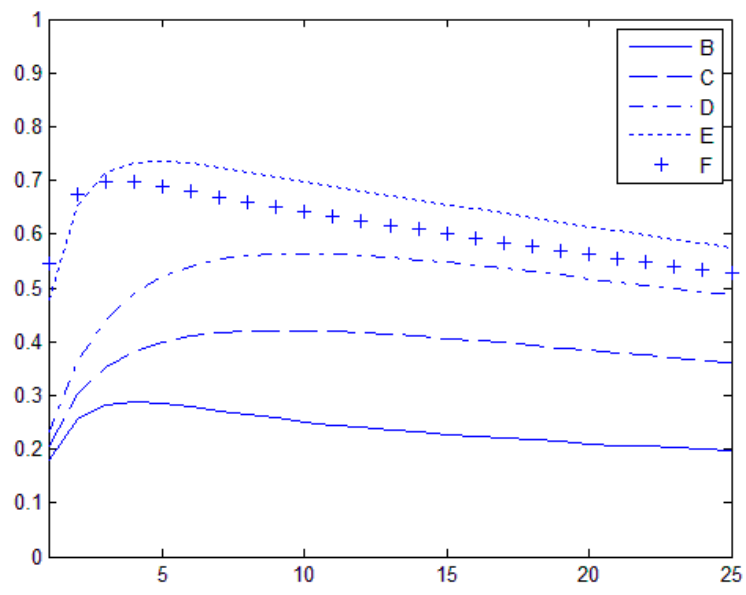
Figure 1. Upgrading probability by time. The vertical axis shows the probability, the horizontal axis shows time in years. The five curves compare the upgrade path probability to a better rating notch.